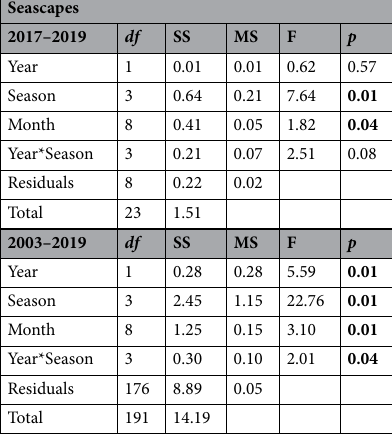
Table 1. Results of the 3-way permutational multivariate analysis of variance (PERMANOVA) to compare the differences in Seascape % Cover (number of pixels) per class between months, seasons. Analysis included